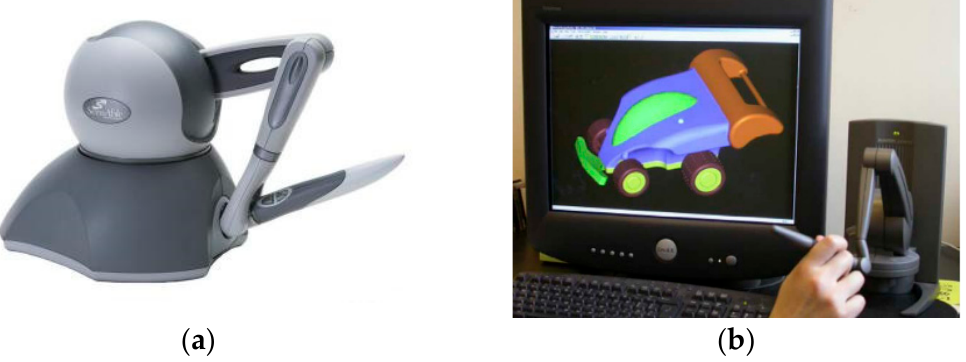
Figure 7. Haptic device for CAD: ( a ) SensAble PHANTom; ( b ) haptic-based device for modeling system. Reproduced with permission from [110], Elsvier,